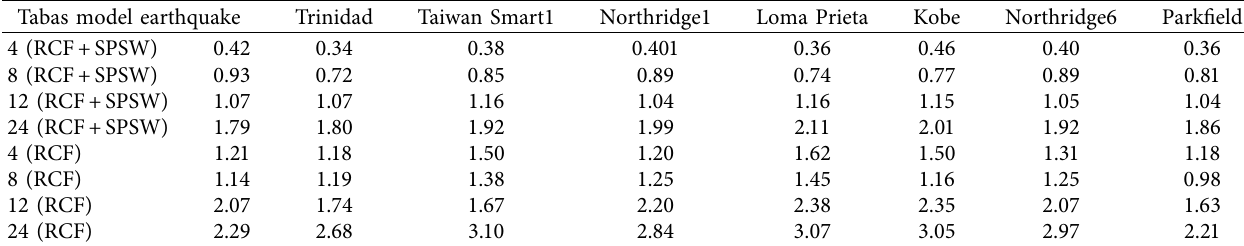
Table 23: Te period of damaged of the models under artifcial SS. Tabas model earthquake